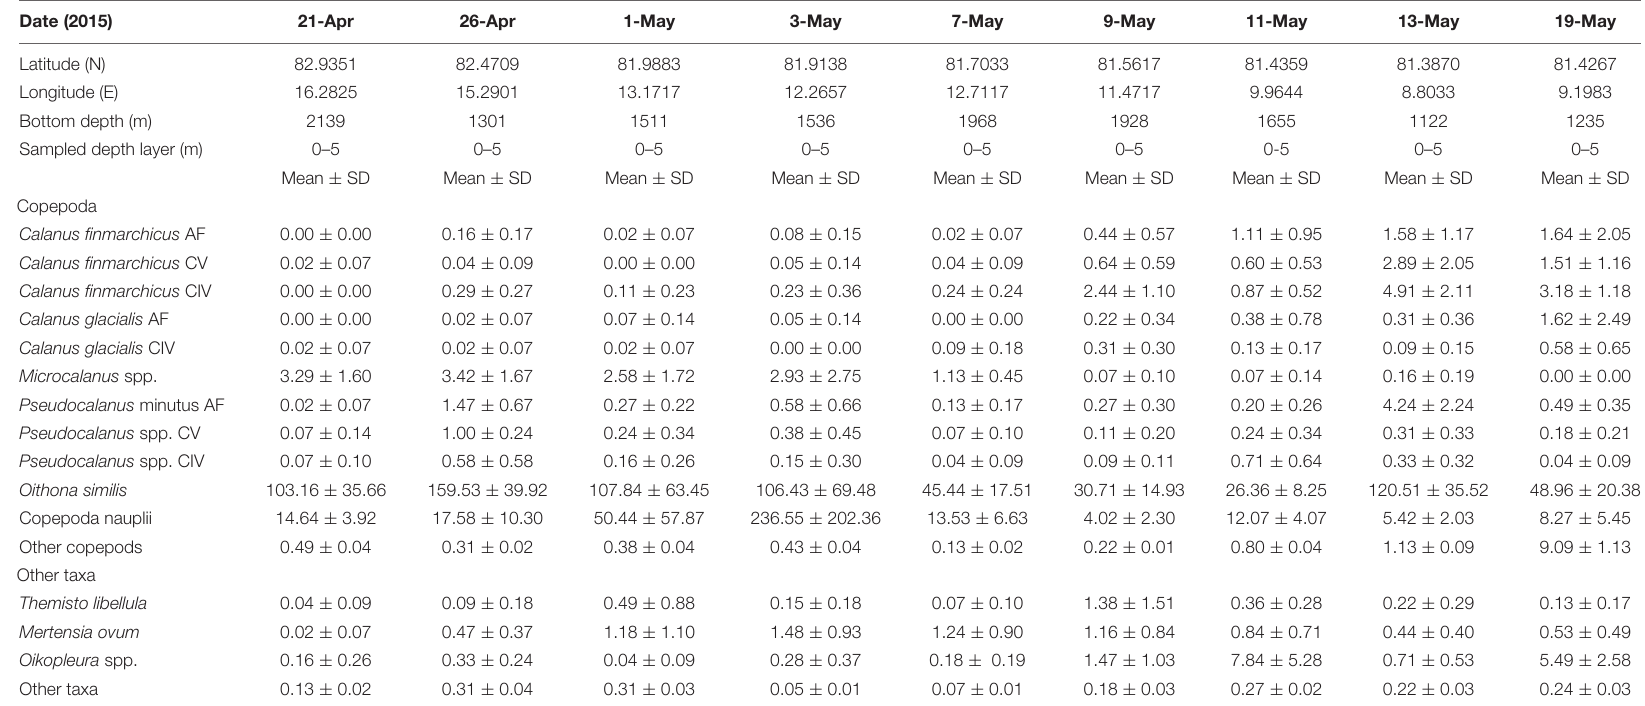
TABLE 3 | Zooplankton taxa abundance (ind. m − 3 ) for swim-net samples collected by divers from 21 April to 19 May